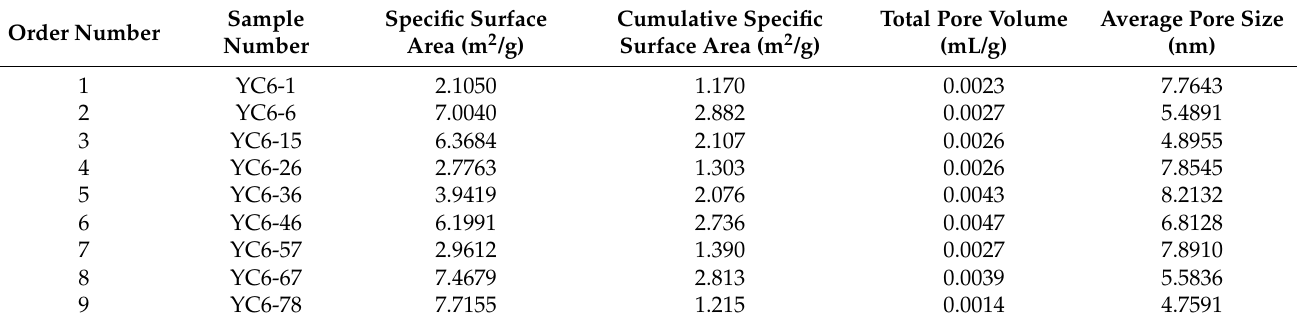
Table 3. Experimental nitrogen adsorption data.